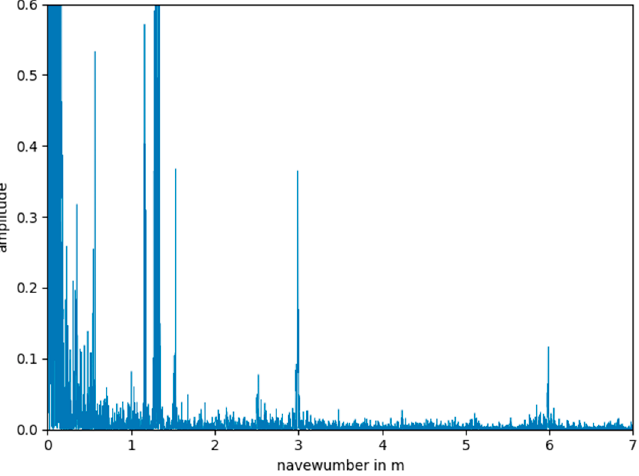
Figure 6. Cepstrum of ABA data calculated from the whole journey with a length of 11,100